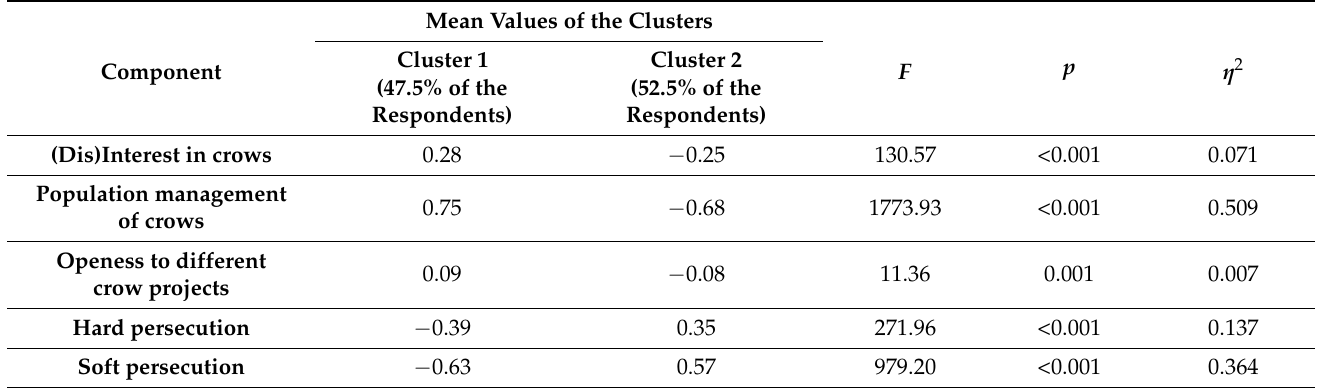
Table 5. The mean values of the clusters determined by the two-step clustering